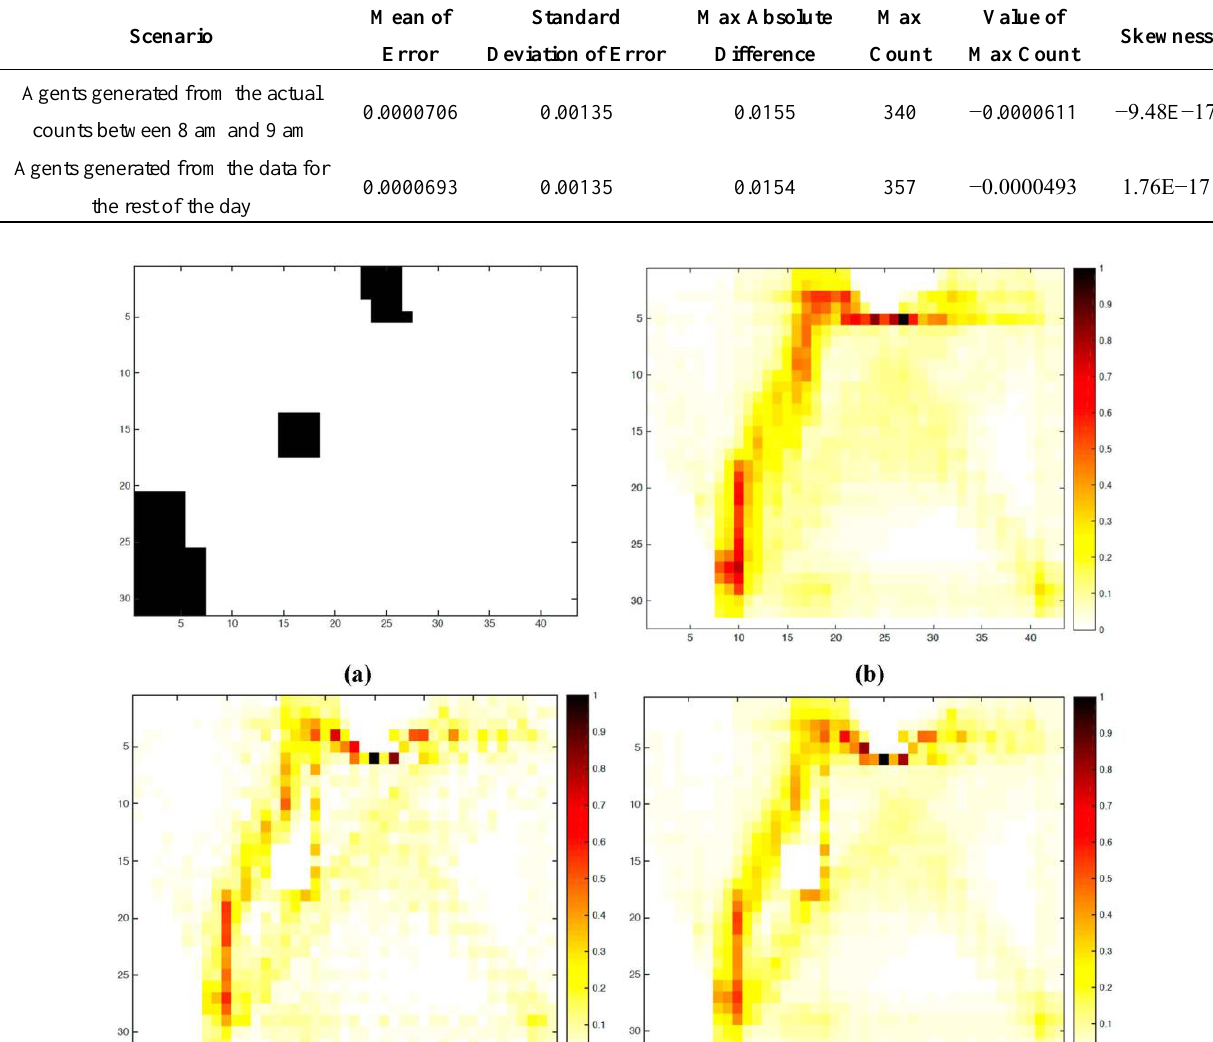
Table 4. Summary statistics from the two different experiments.